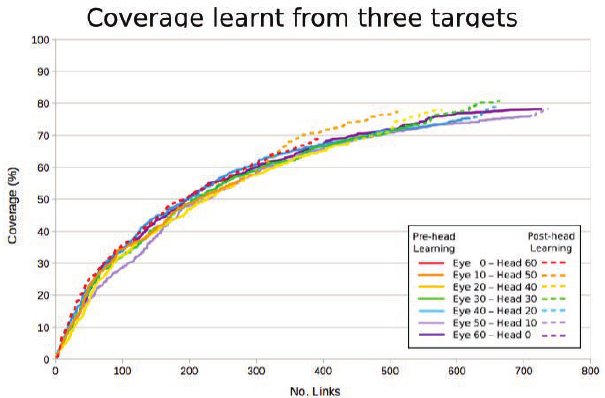
Figure 10. Graph showing the percentage of map covered as more links are learnt, based on learning with three targets for 60 minutes with the head constraint being released after 10 minute intervals across dif- ferent trials (solid lines represent eye-only phase). Best viewed in colour.